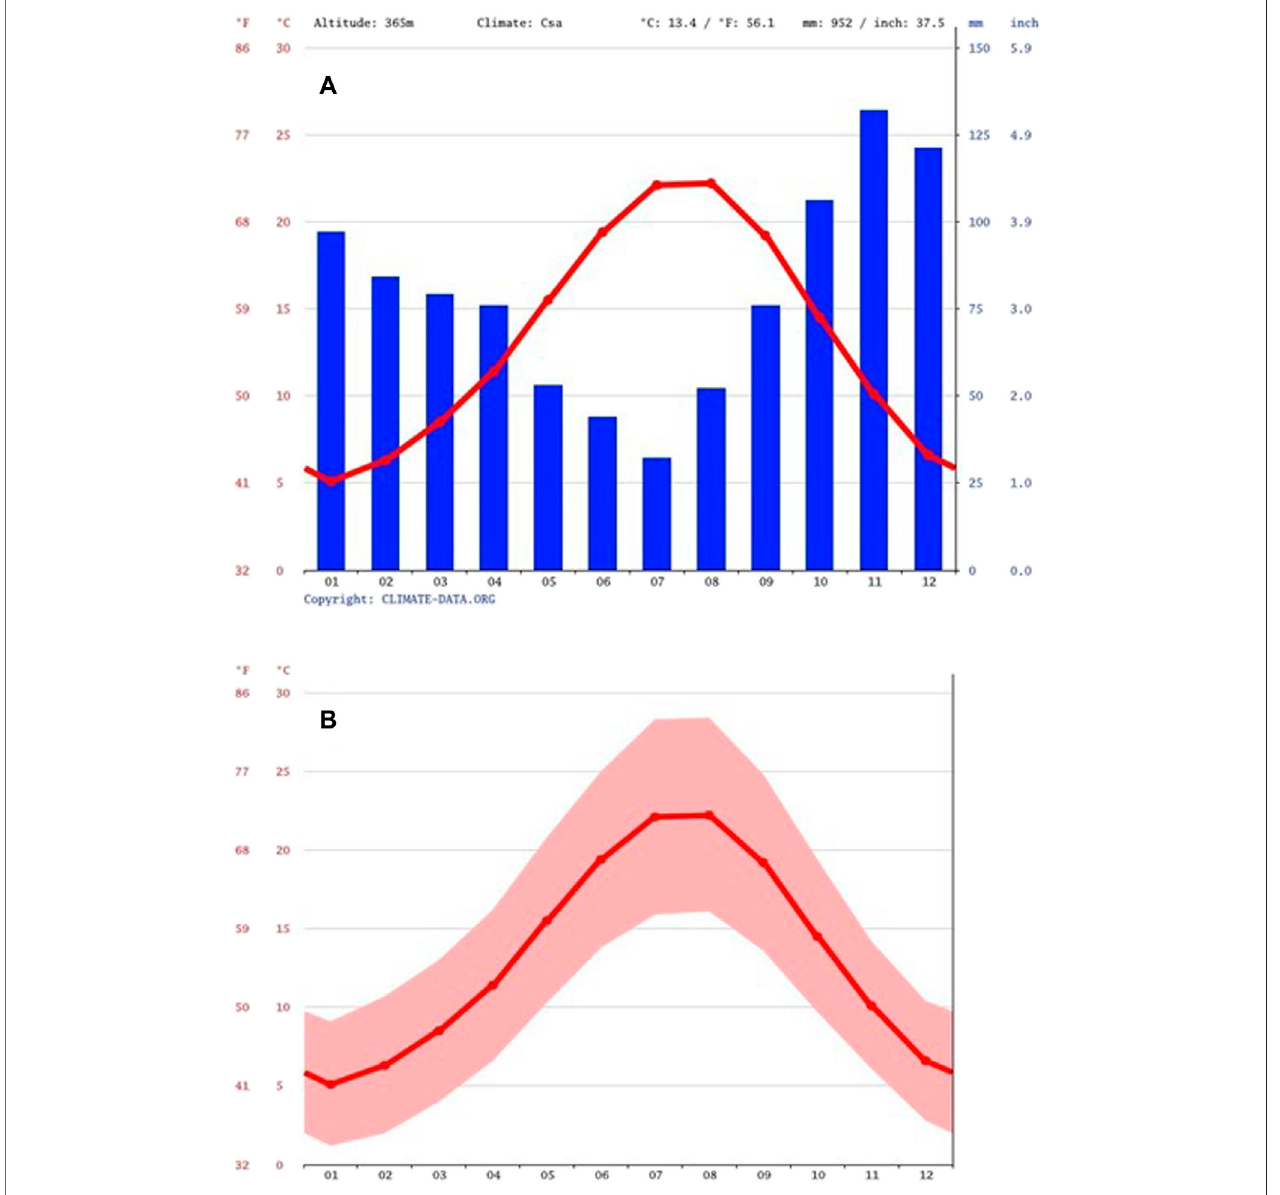
FIGURE 1 | (A) Climate plot of Atina municipality related to year 2020; (B) Temperatures registered in Atina in year 2020.